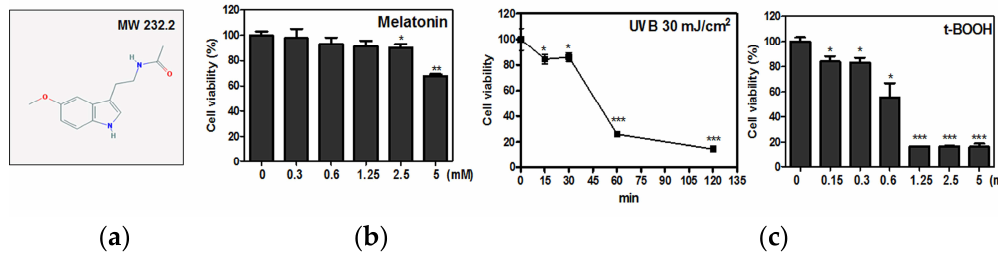
Figure 1. The effect of Melatonin, t-BOOH and UVB on the cytotoxicity in HaCaT cells. ( a ) Chemical structure of melatonin. Molecular weight = 232.2 ( b , c ) HaCaT cells were seeded onto 96-well microplates at a density of 1 × 10 4 cells/well and treated with various concentrations of Melatonin (0, 0.3, 0.6, 1.25, 2.5 or 5 mM) or t-BOOH (0, 0.15, 0.3, 0.6, 1.25, 2.5 or 5 mM) for 24 h. HaCaT cells were exposed to UVB (30 mJ/cm 2 ) for 15 min, 30 min, 60 min or 120 min. Data represent means ± SD. * p < 0.05, ** p < 0.01 and *** p < 0.001 versus untreated control.